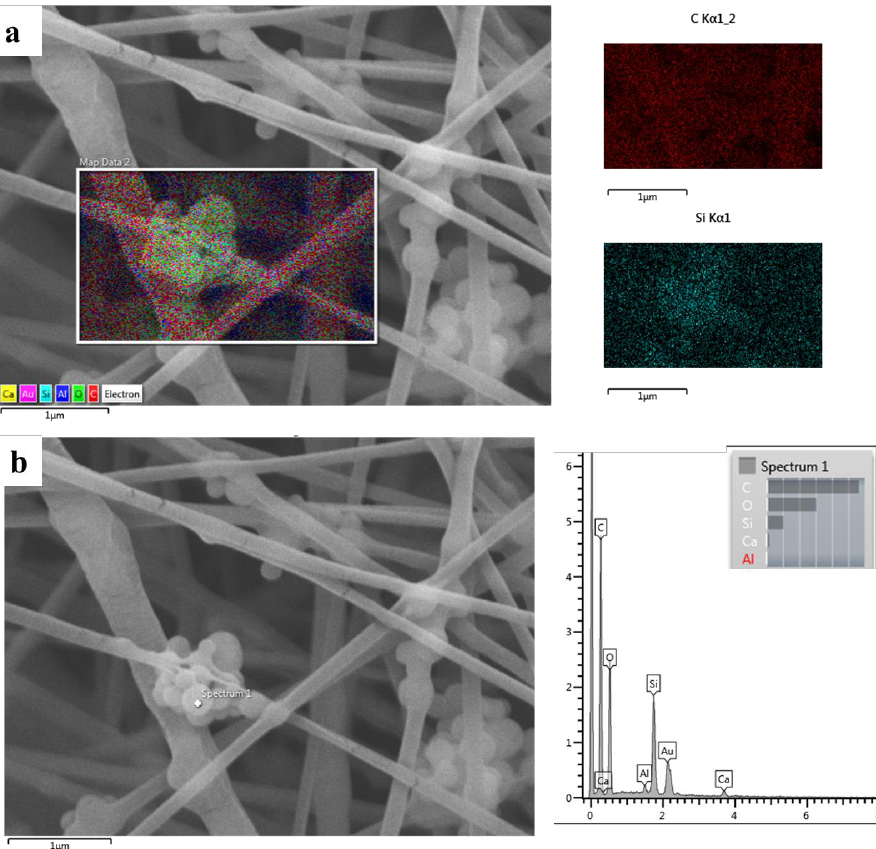
Figure 6. SEM/EDS analysis of the composite electrospun mats. SEM with maps and details for C (polymer component) and Si (from particles) ( a ) showing also the EDS spectrum on the particle cluster ( b ).